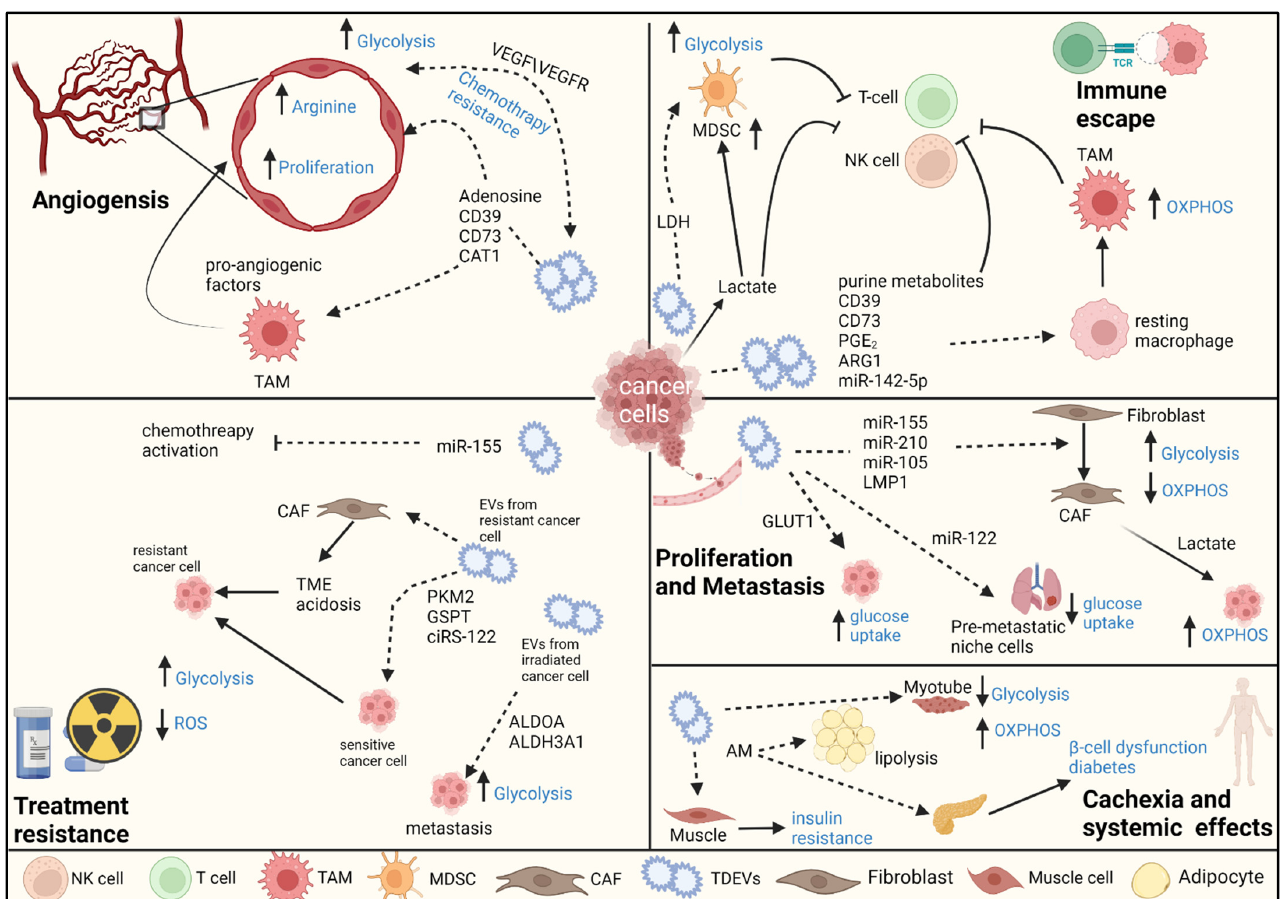
Figure 1. Tumor microenvironment metabolic reprogramming by tumor-derived extracellular ves- icles. Tumor-derived EVs (TDEVs) have been implicated in almost all tumor aspects, including cell proliferation and metastasis, angiogenesis, immunoescape, and therapy resistance. TDEVs transfer cargo into endothelial cells that increase arginine metabolism and glycolysis, which promotes en- dothelial proliferation and angiogenesis. TDEVs transfer glycolytic enzymes and genetic material from treatment-resistant cancer cells to sensitive cancer cells, which thereby enhances glycolysis, causes a decrease in ROS, and increases chemotherapy metabolism, thus conferring treatment re- sistance. EVs carry and deliver purine metabolites, genetic material, and glycolytic enzymes that increase glycolysis in MDSC and polarize macrophages to TAMs, which, together with TDEVs, have a direct effect on inhibiting the immunoresponse to cancer. TDEVs activate fibroblasts to CAFs, which induces glycolysis in CAFs and, in turn, promotes proliferation and metastasis. TDEVs act on cancer cells to increase glucose uptake while suppressing glucose uptake by premetastatic niche cells, which promotes metastasis. TDEVs travel beyond the immediate TME to inhibit glycolysis and enhance OXPHOS in myoblasts, which disrupts myotube differentiation and partly explains cachexia. TDEVs induce insulin resistance in skeletal muscle cells and transfer AM to induce lipolysis and β -cell dysfunction, which is manifested as cancer-related diabetes. NK cell—natural killer cell;